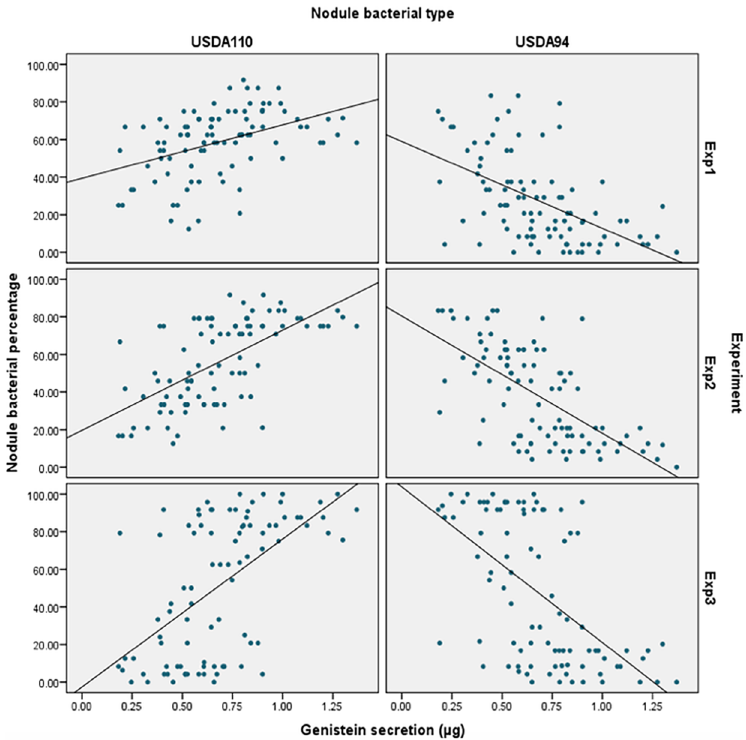
Fig 2. Relationship between genistein secretion and percentage of UDSA110-type and USDA94-type nodules from three independent experiments.